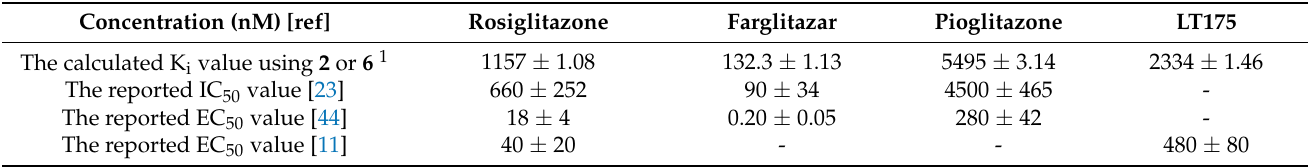
Table 4. Comparison of the K i value determined using 2 or 6 with reported IC 50 or EC 50